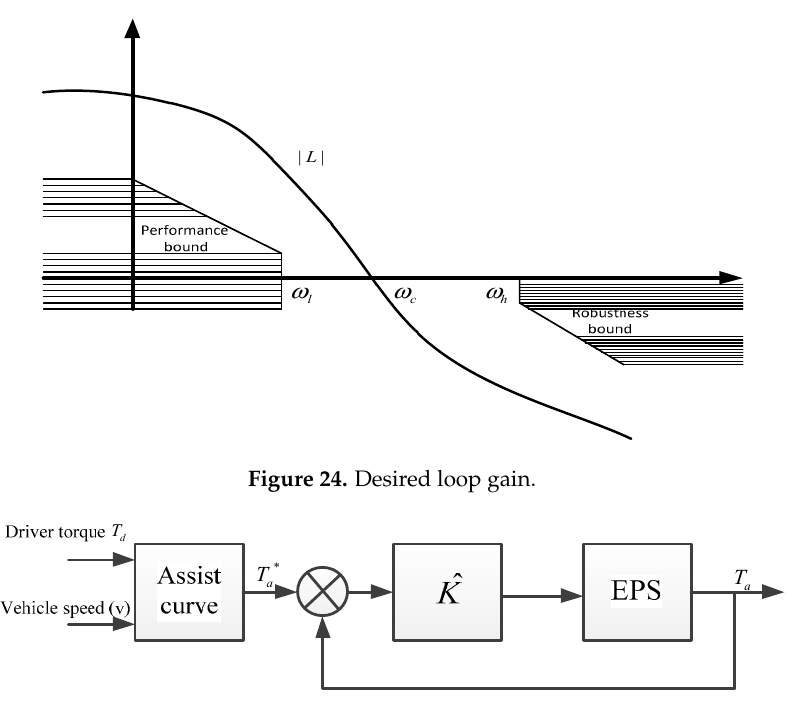
Figure 25. Diagram of the loop-shaping controller for EPS.